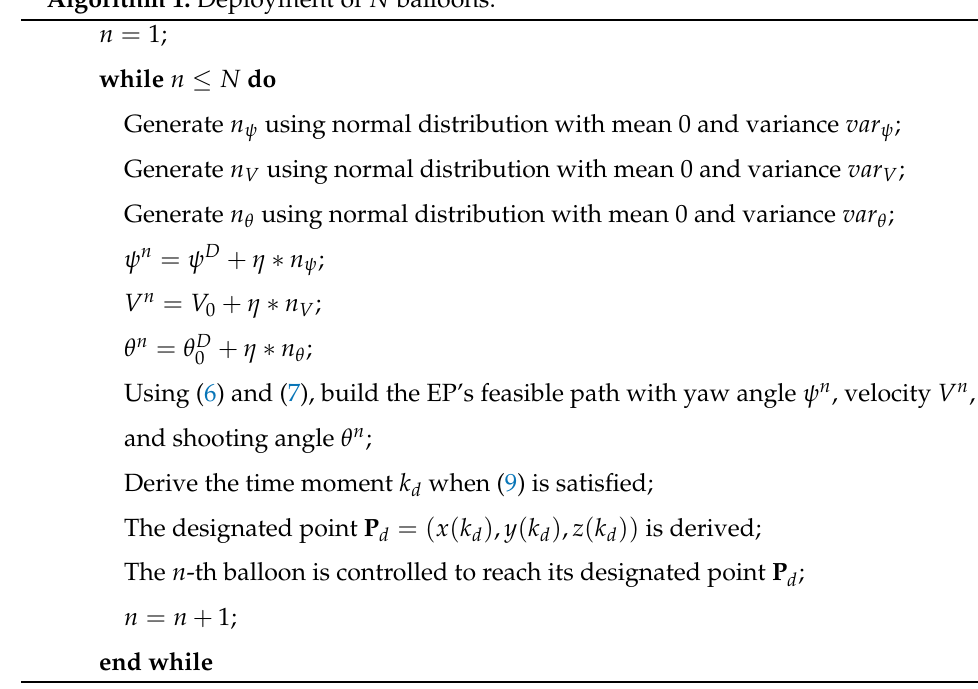
Algorithm 1: Deployment of N